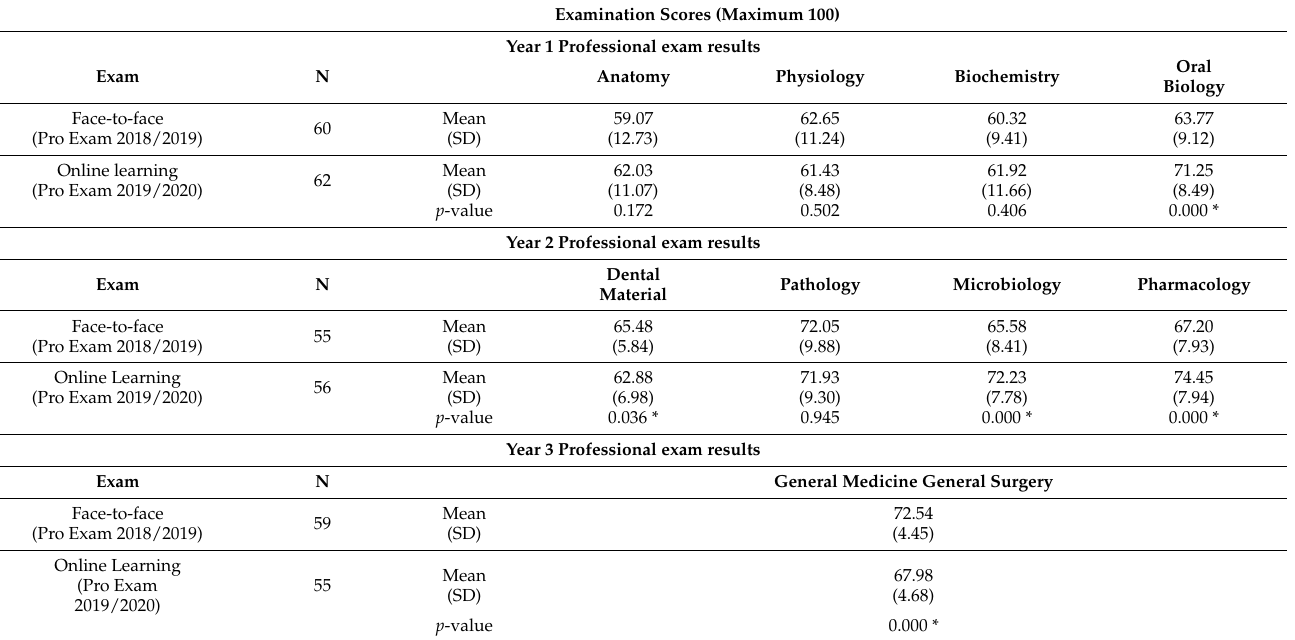
Table 3. Professional exam